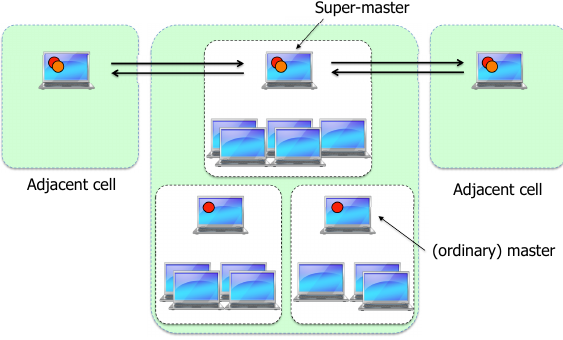
Fig. 6. Proposed hierarchical P2P architecture (ordinary master is marked with red circle and sups-master is marked with orange